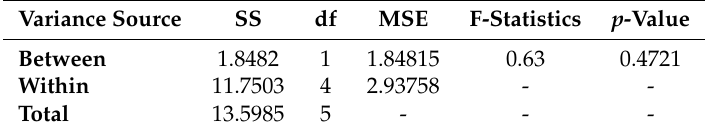
Table 8. ANOVA test on two selected classifiers based on the proposed